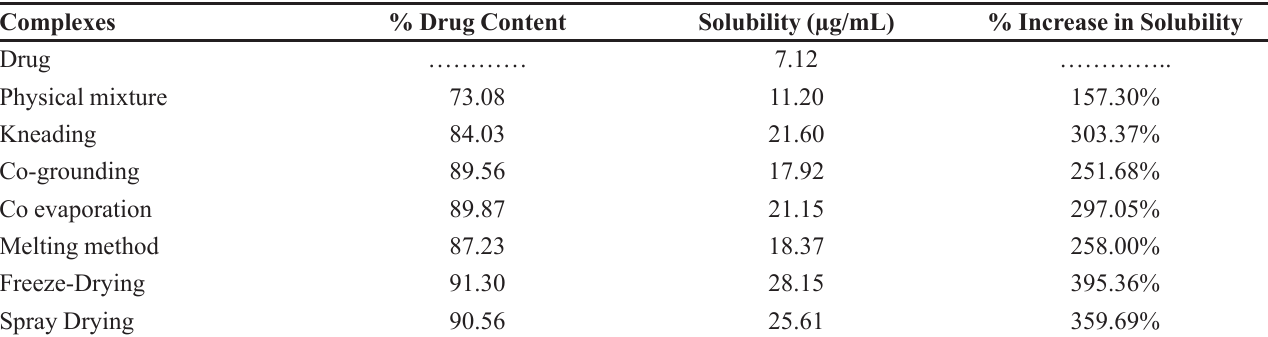
TABLE III - Percentage drug content and saturation solubility of drug: β-CD(1:1) complex